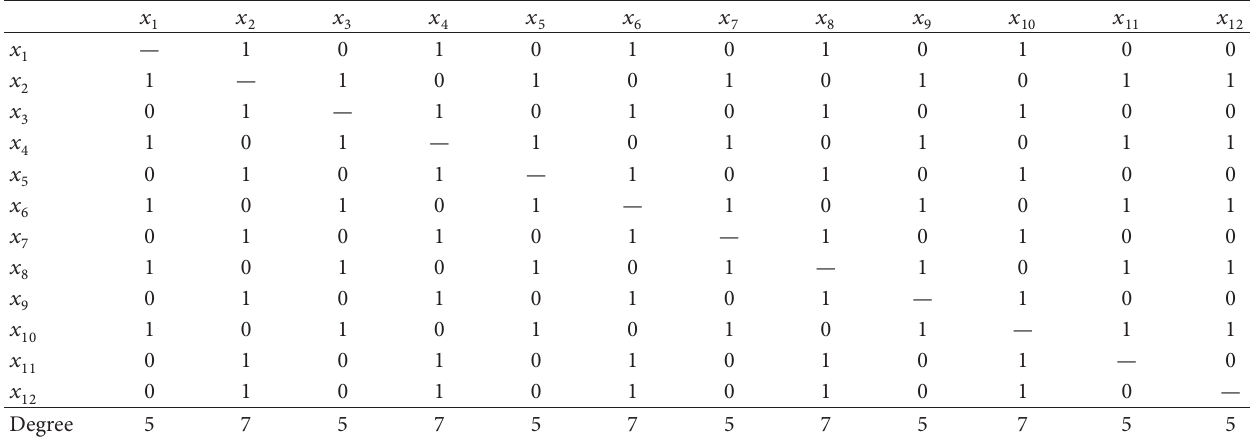
Table 1: Adjacency matrix of the graph of Figure